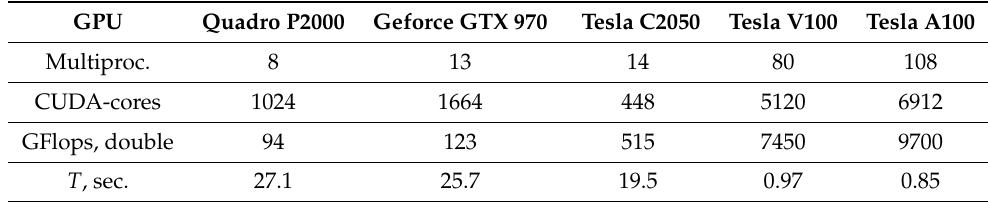
Table 5. Computational time for different